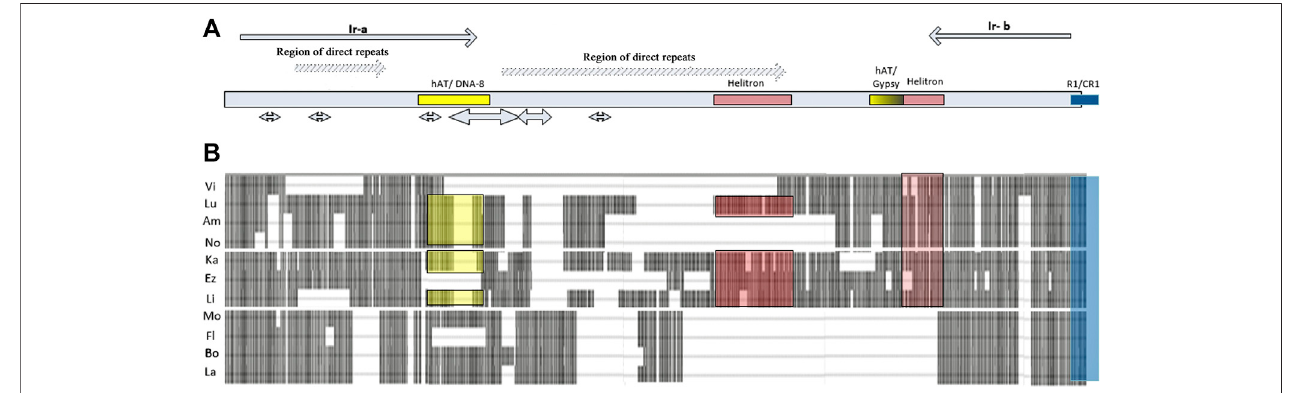
FIGURE3| Thestructureofthe ras85D upstreamintergenicregionin Drosophila speciesofthe virili sgroup. (A) Repeats,palindromes,andareasofhomologywith mobile elements: inverted repeats fl ankingthe sequence are designated asIr-a and Ir-b and are represented in the scheme by gray arrows; regions ofdirect repeats are represented by lightgray arrows with diagonal hatching; palindromes are shown bydouble-headed arrows; areas ofhomology with terminal repeats oftransposons are marked by colored rectangles. (B) Insertion-deletion polymorphism of the regulatory region: rectangular gray blocks represent the DNA sequence, dashed lines and gaps between the blocks show the